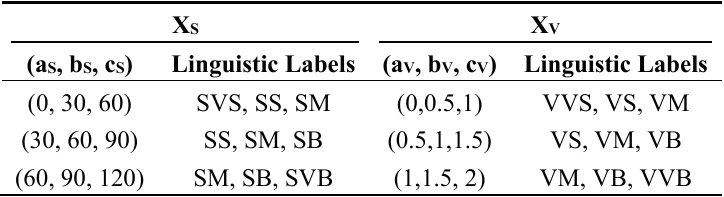
Table 1. Input values and linguistic